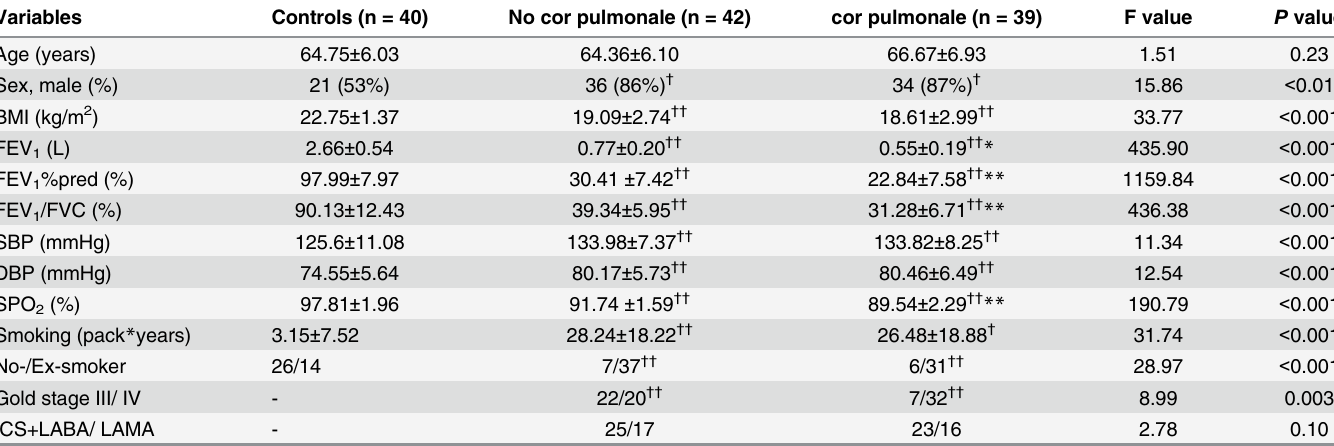
Table 1. Clinical Data in Controls and Two Subgroups of COPD (Cor Pulmonale and No Cor Pulmonale) (Mean ± SD). Variables